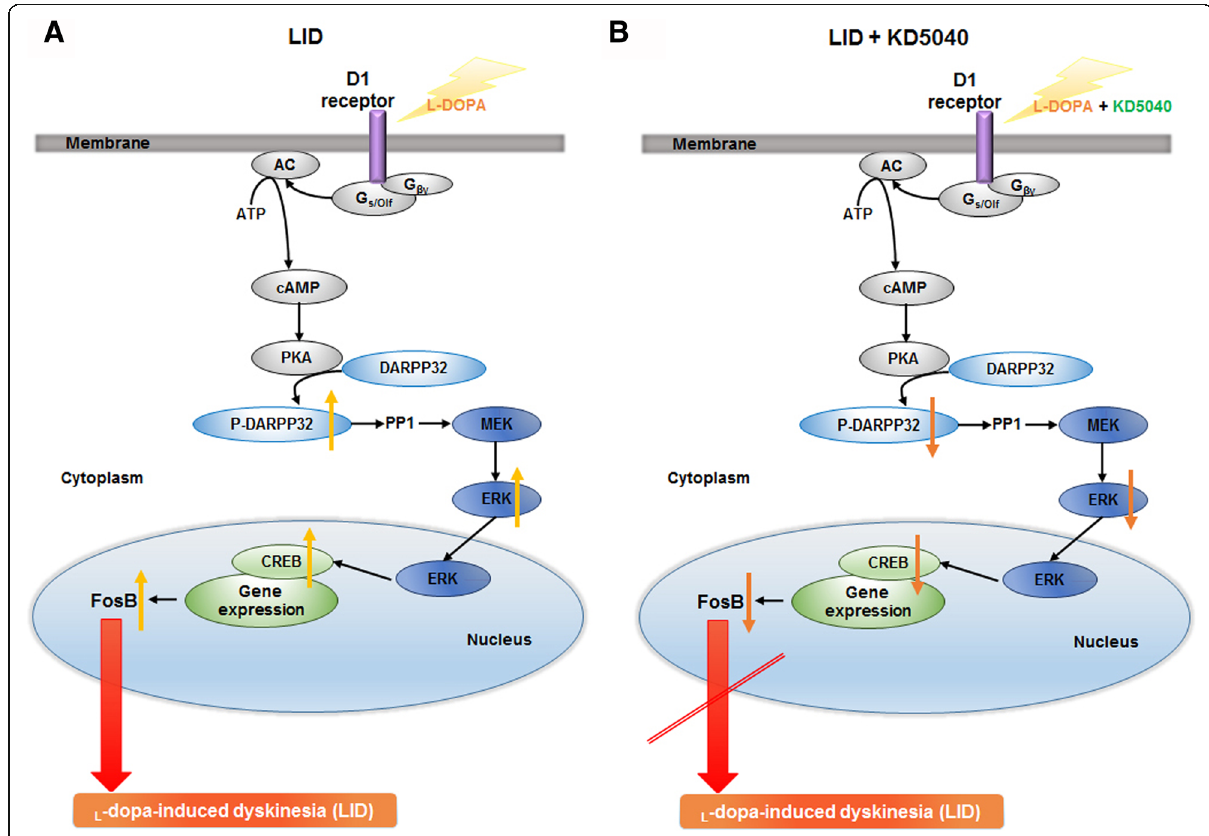
Fig. 13 Effects induced by -dopa in the striatal MSNs of the direct pathway. a MPTP plus a high dose of L -dopa (20 mg/kg) not only replaced L dopamine in terms of excessive concentrations but also overactivated the D1 receptor to cause hyperactivity in the direct striatonigral pathway. b Combination treatment resulted in a significant normalization of the D1 pathway, resulting in antidyskinetic effects. MSNs: medium spiny